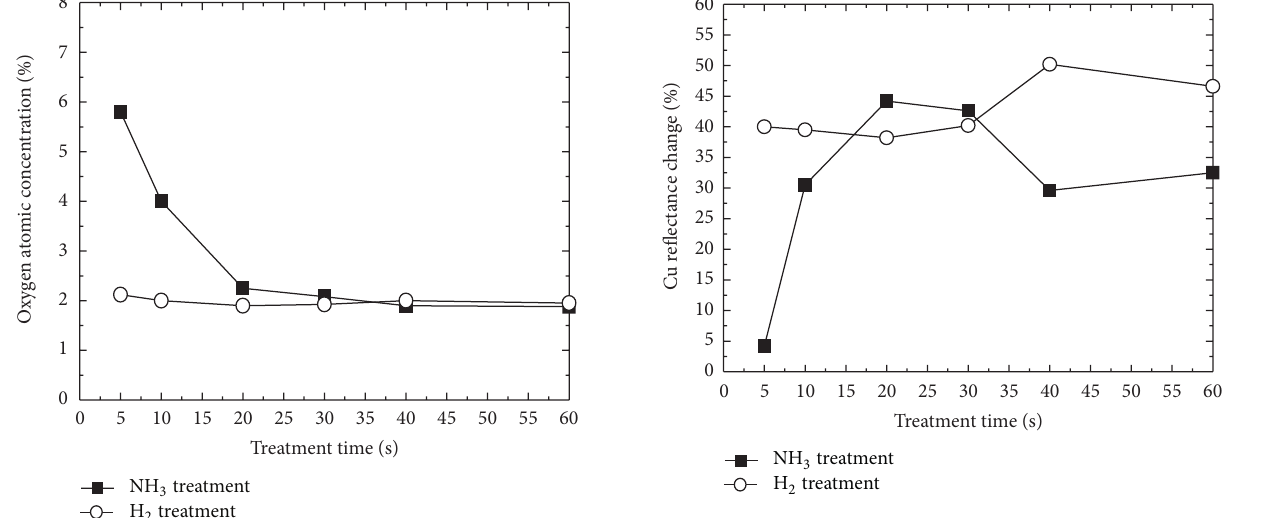
Figure 3: Percentage change in Cu resistance on the oxidized Cu surfaceforH 2 andNH 3 plasmatreatmentsasafunctionoftreatment time.